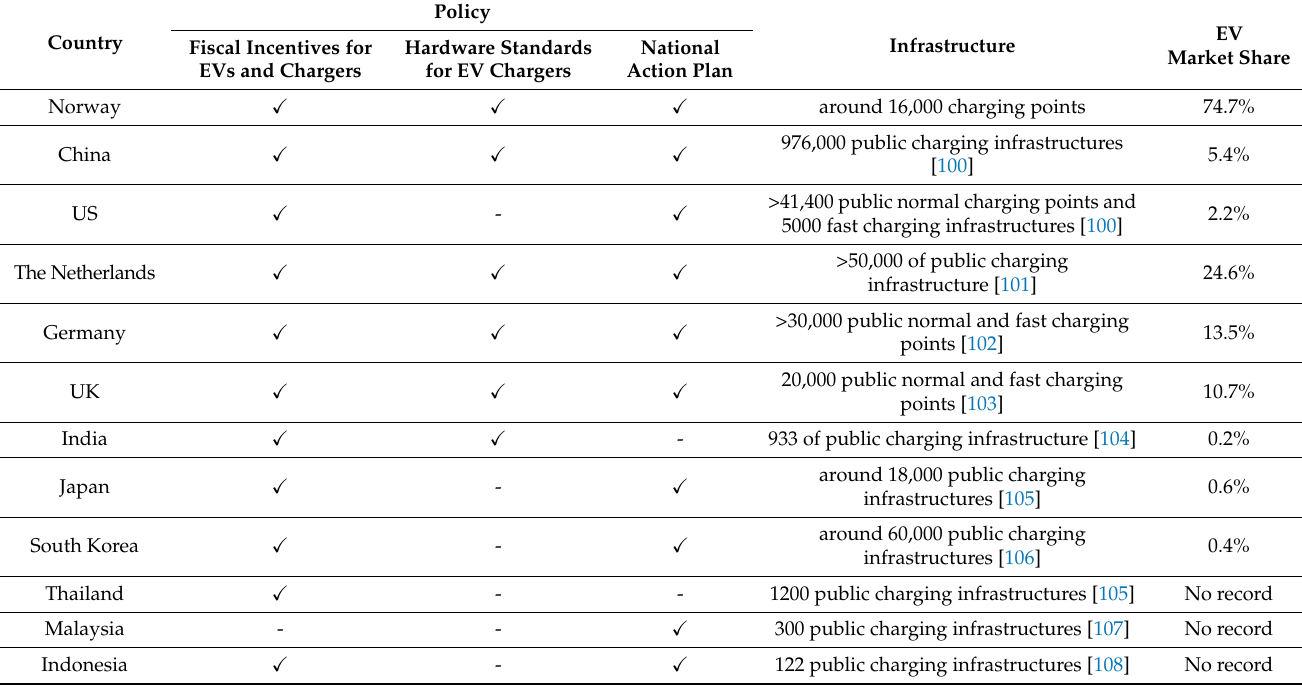
Table 7. EV development in several